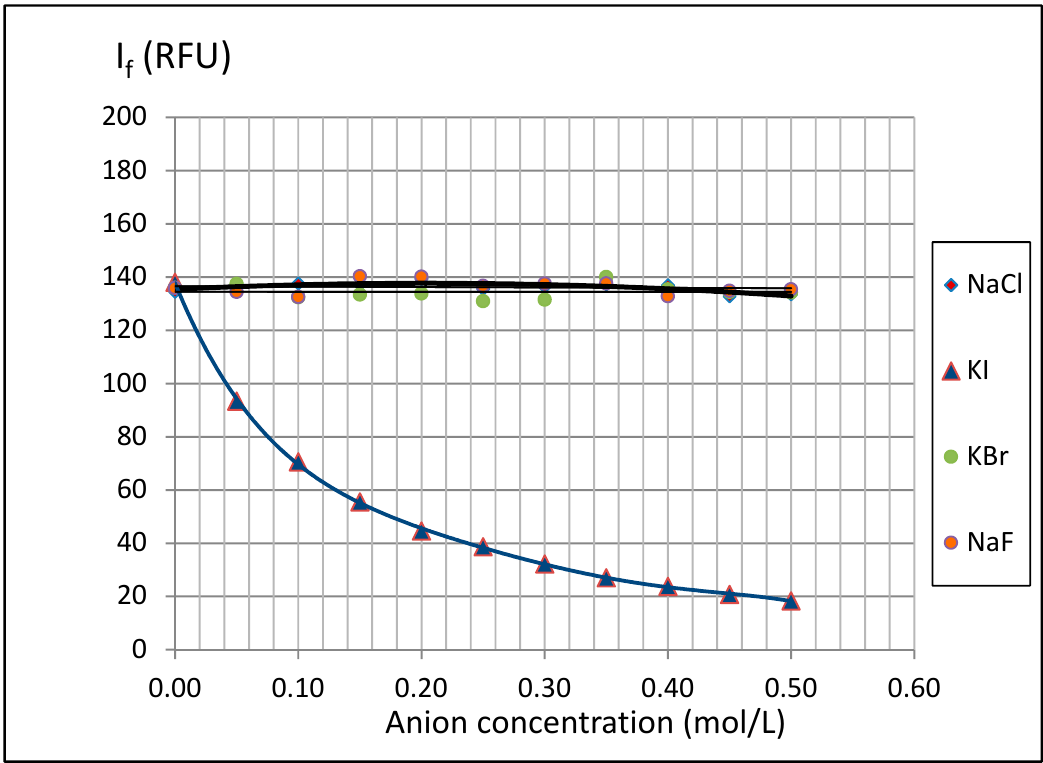
Figure 12. The relationship between fluorescence intensity I f of 3-aminoflavone and the concentration of chloride, bromide, iodide and fluoride ions. The concentration of 3-aminoflavone was 5 µ g / mL in cuvette with a path length of 1 cm. For excitation and emission, filters with wavelengths of 350 nm and 470 nm were used, respectively.